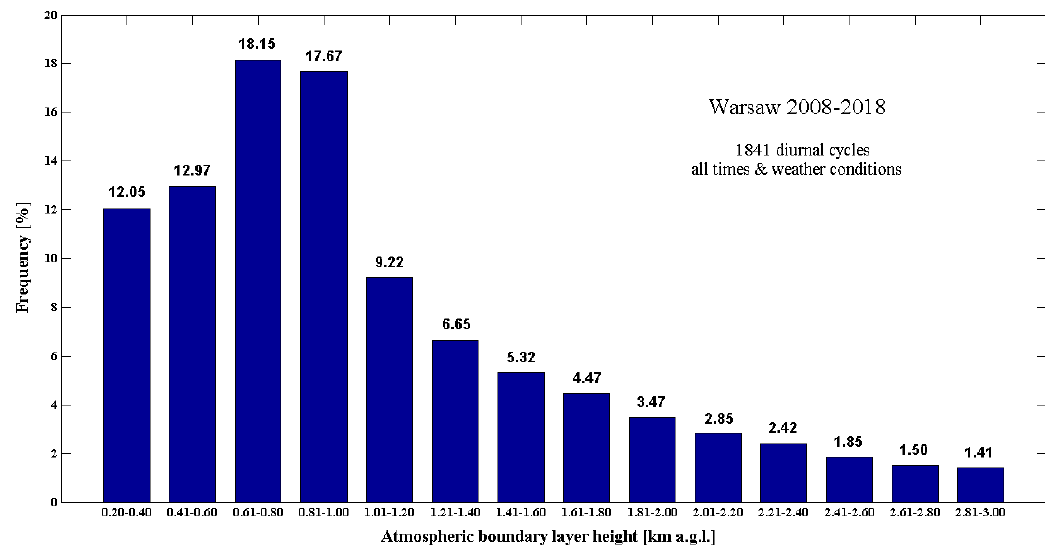
Figure 12. Frequency distribution of ABLH calculated from the PollyXT lidar and the CHM15k ceilometer observations in Warsaw from 2008 to 2018. The ABLH values are separated into classes of 200 m. The merging and the homogenization were applied to lidar data from November 2013 to December 2018.